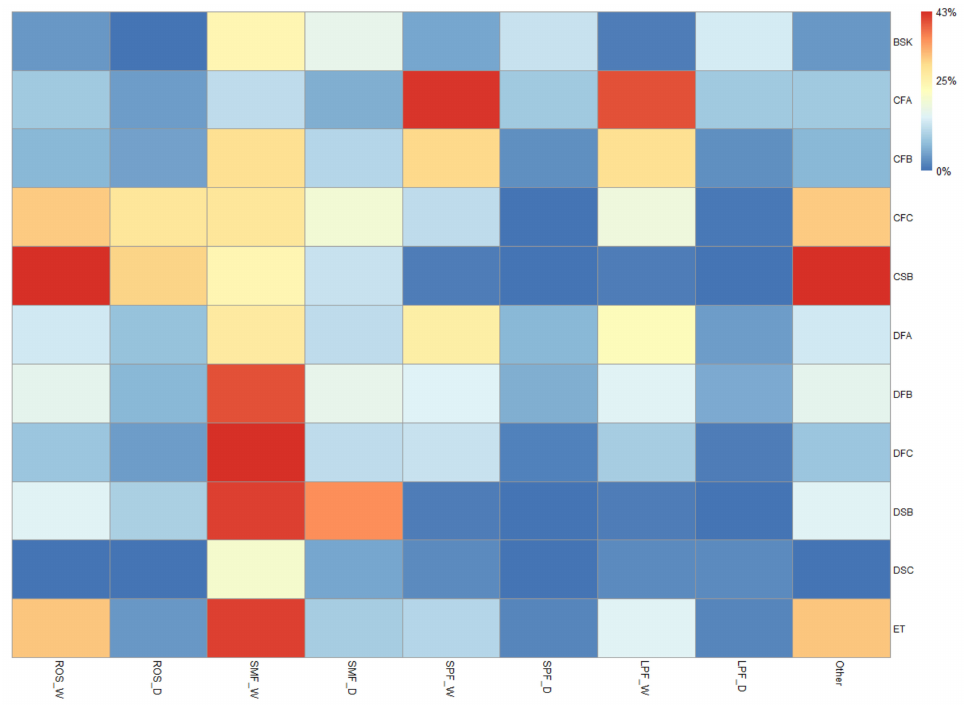
Figure 8. Heatmap for the annual maximum (AM) flood typology classification by climate zone, showing results for the four climate zones with the highest number of